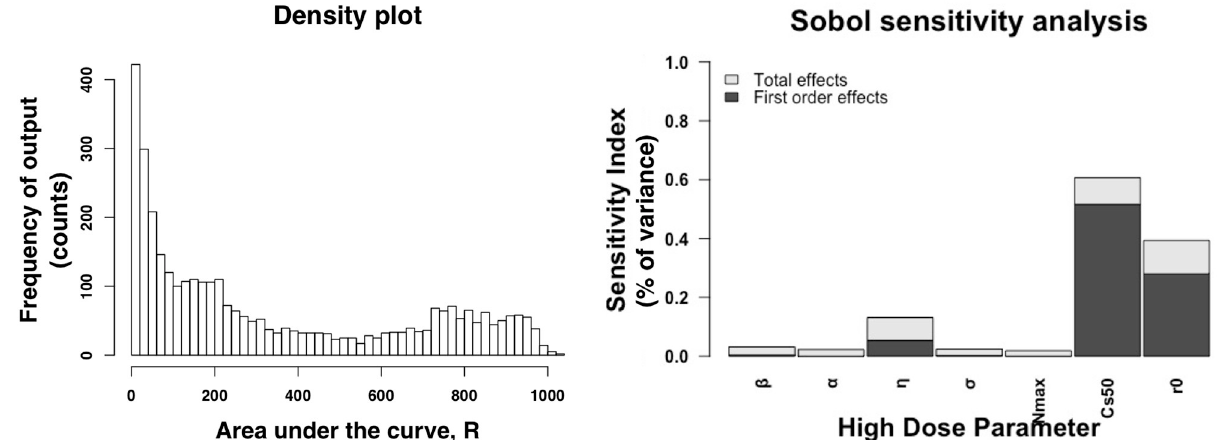
Fig 6. High dose sensitivity analysis. Sobol sensitivity analysis results of the high dose regime. The left panel is a histogram of the output variable of the sensitivity analysis, the area under the curve of the bacteria above the ECOFF, R . The right panel is the sensitivity index for each parameters. The first order effects measures varying the parameter alone but averaged across all of the other variations while the total effect measures the effect of varying the parameters including variance caused by the parameters interactions.